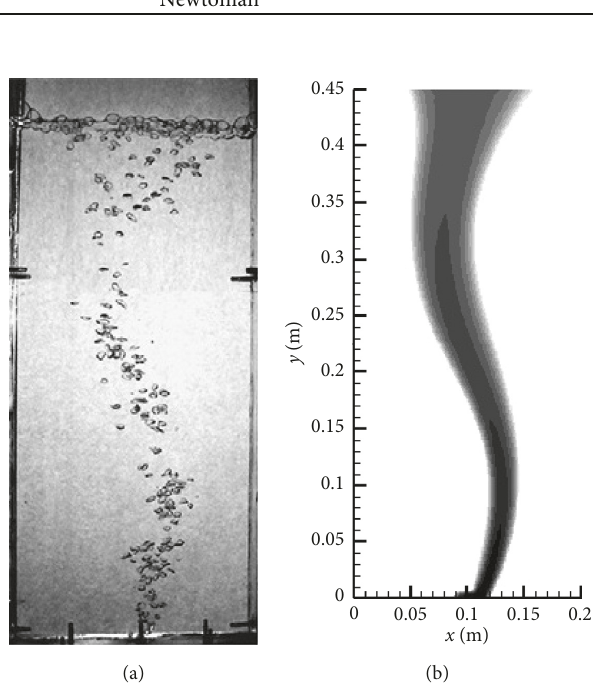
Figure 2: Comparison between experimental and computational results of instantaneous gas